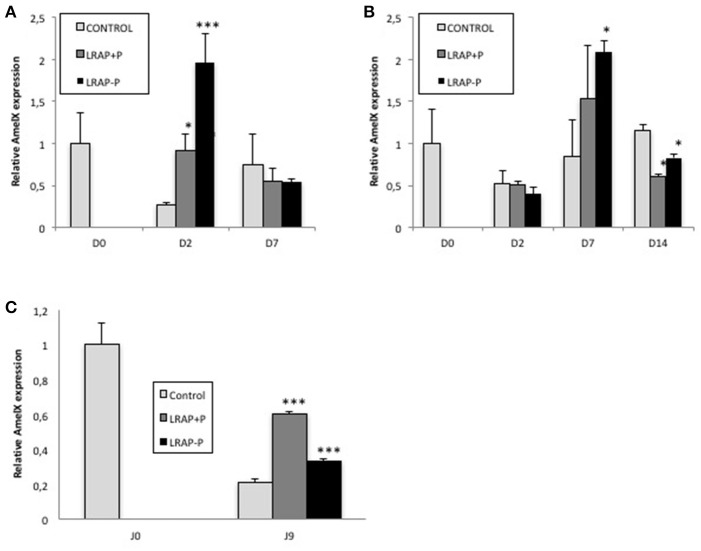
Kinetic of expression of amelogenin gene in LS8 and ALC cells and in the cultured first molar germs. (A,B)
Amelx quantitative PCR analyses for the LS8 (A) and ALC (B) cell lines at selected time-points. Amelx expression was normalized to GAPDH and Actin for each time-point and cell line. Average expression levels and standard deviation error were calculated from 3 different qPCR experiments (each run in triplicate, n = 3). At D2, both peptides induced a statistically significant increase in amelogenin transcripts relative to the control in the LS8 [*p < 0.05 for LRAP(+P) and ***p < 10−4 for LRAP(–P)]. At D7, both peptides induced a similar increase for the ALC, statistically significant for LRAP(–P) (*p < 0.05) relative to the control. (C)
Amelx transcripts levels were compared between D0 (PND1 germ) and cultured D9 germs. Inhibition of Amelx expression was observed in all conditions relative to the D0 germ. LRAP(+P) and LRAP(–P) treatment induced a statistically significant (*p < 0.05) increase in Amelx expression relative to the control.